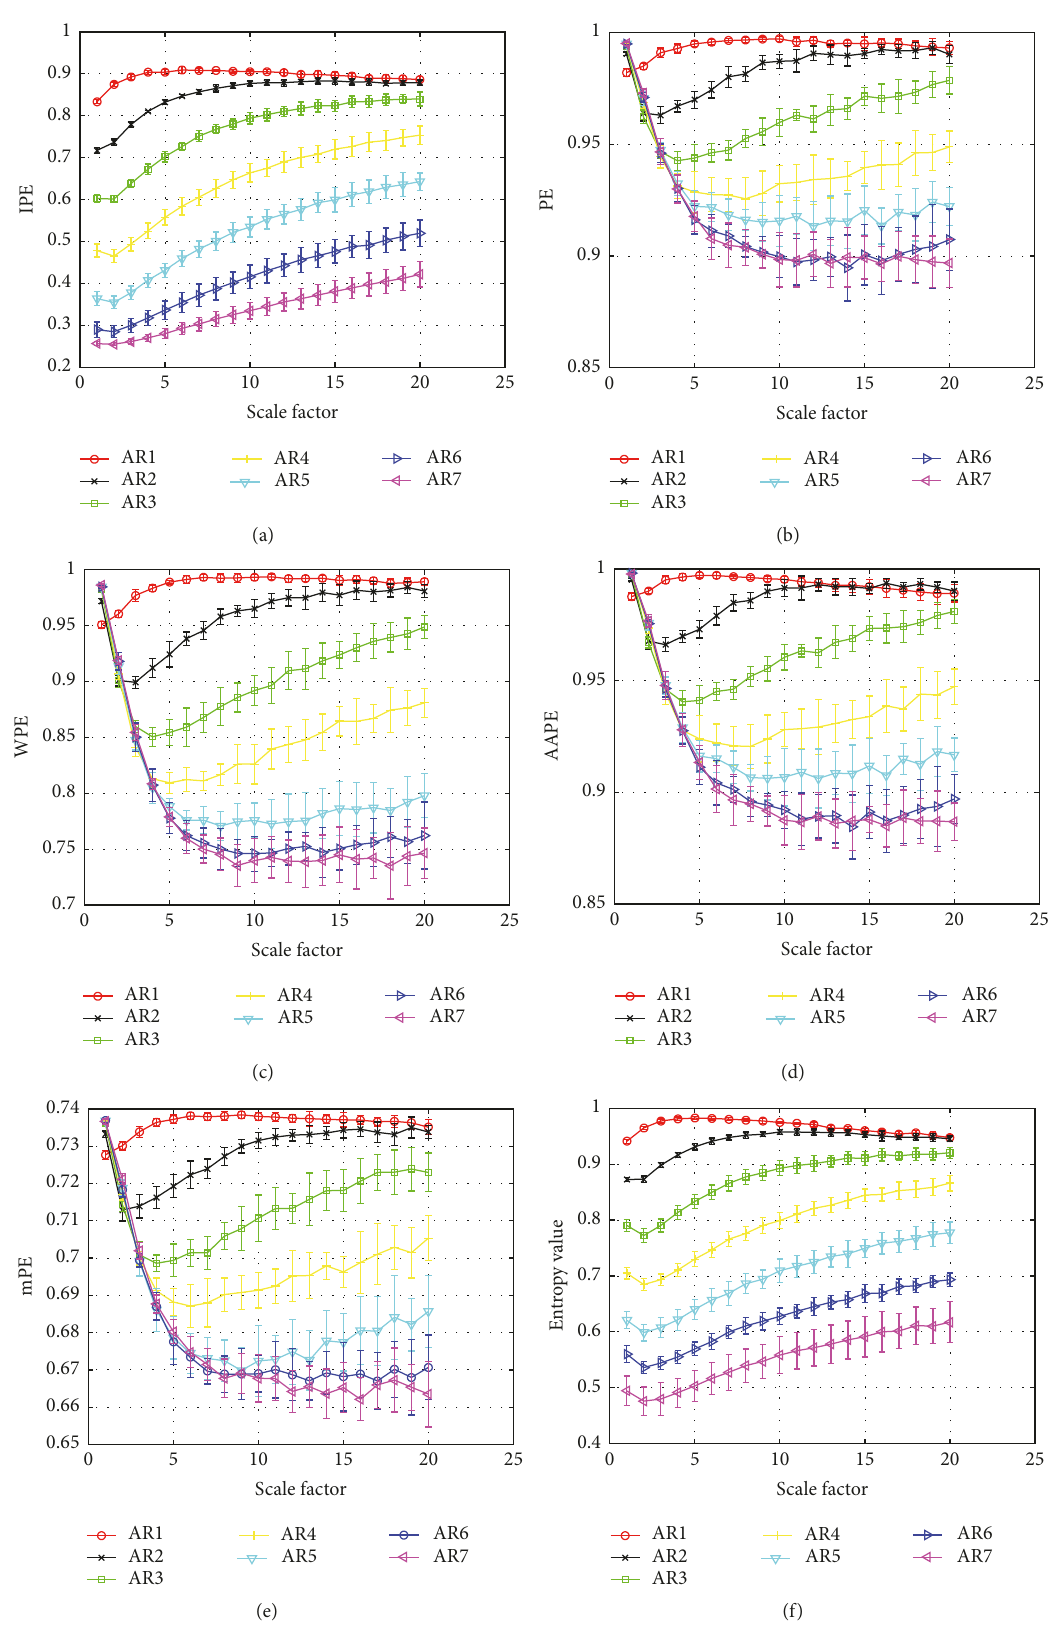
Figure 7: Entropy analysis of AR time series. (a) Result of IPE. (b) Result of PE. (c) Result of WPE. (d) Result of AAPE. (e) Result of mPE. (f) Result of